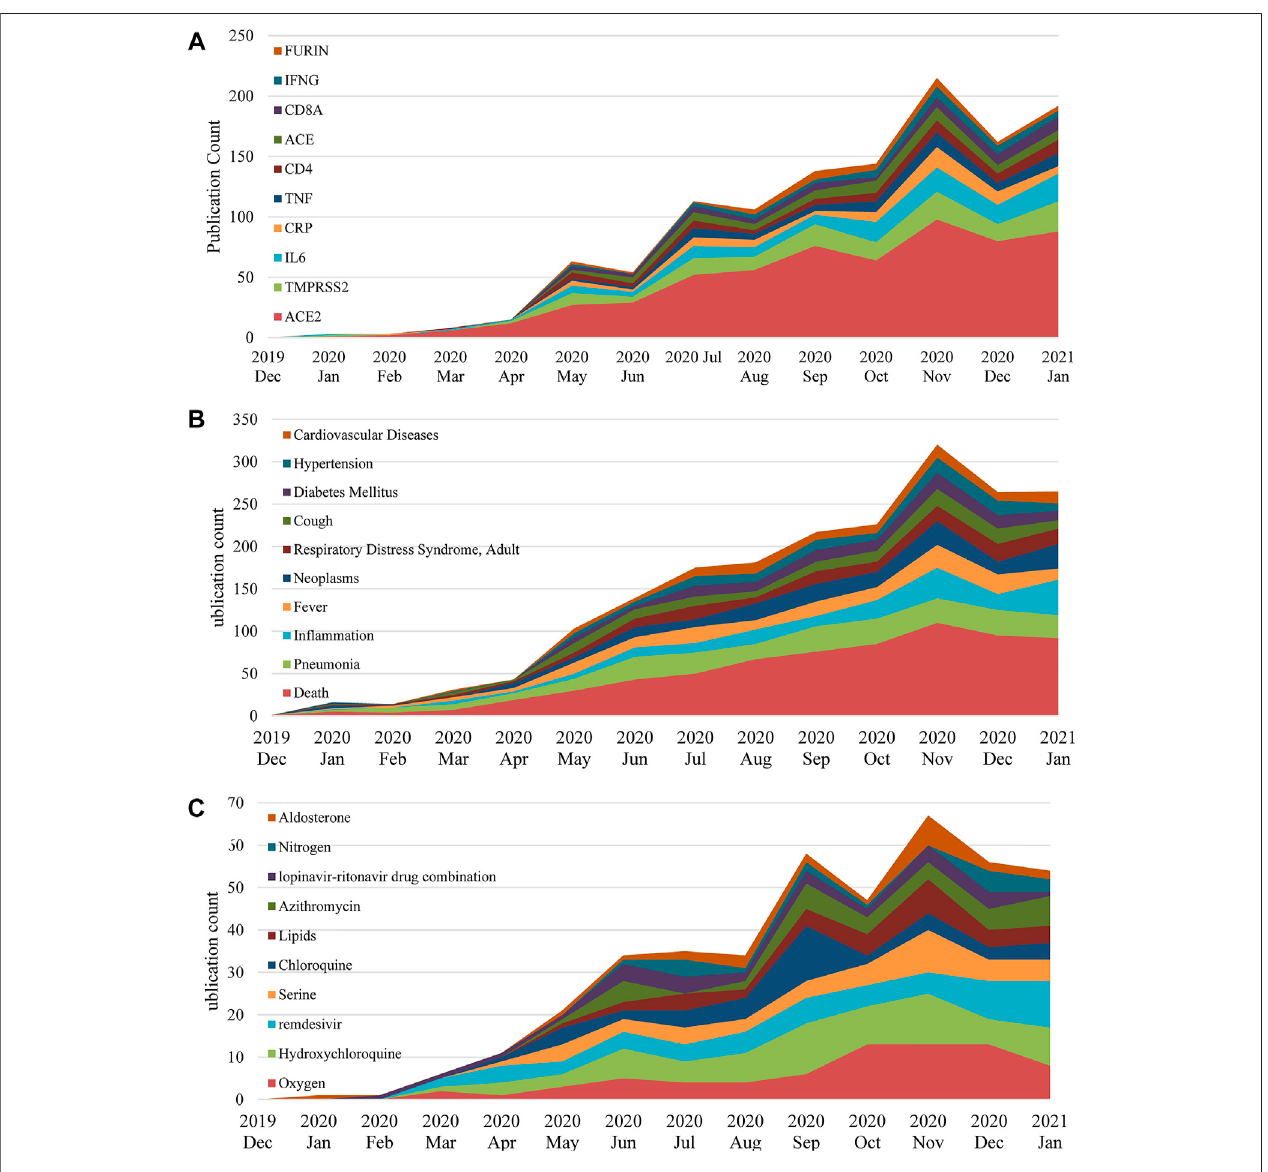
FIGURE 6 | Top 10 genes (A) , co-morbidities (B) and chemicals (C) in COVID-19 genetic research between December 2019 and January 2021.